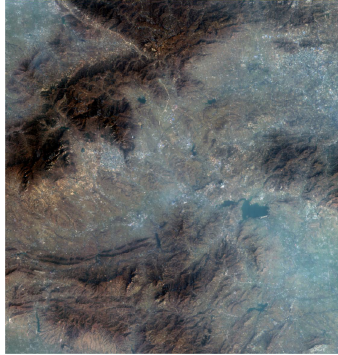
Figure 5. Multispectral image of ZY-3 satellite